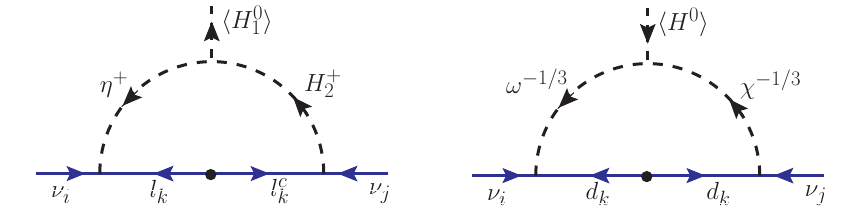
Figure 7.1: Neutrino mass generation at one-loop level: Zee model (left) and a col- ored variant with LQs